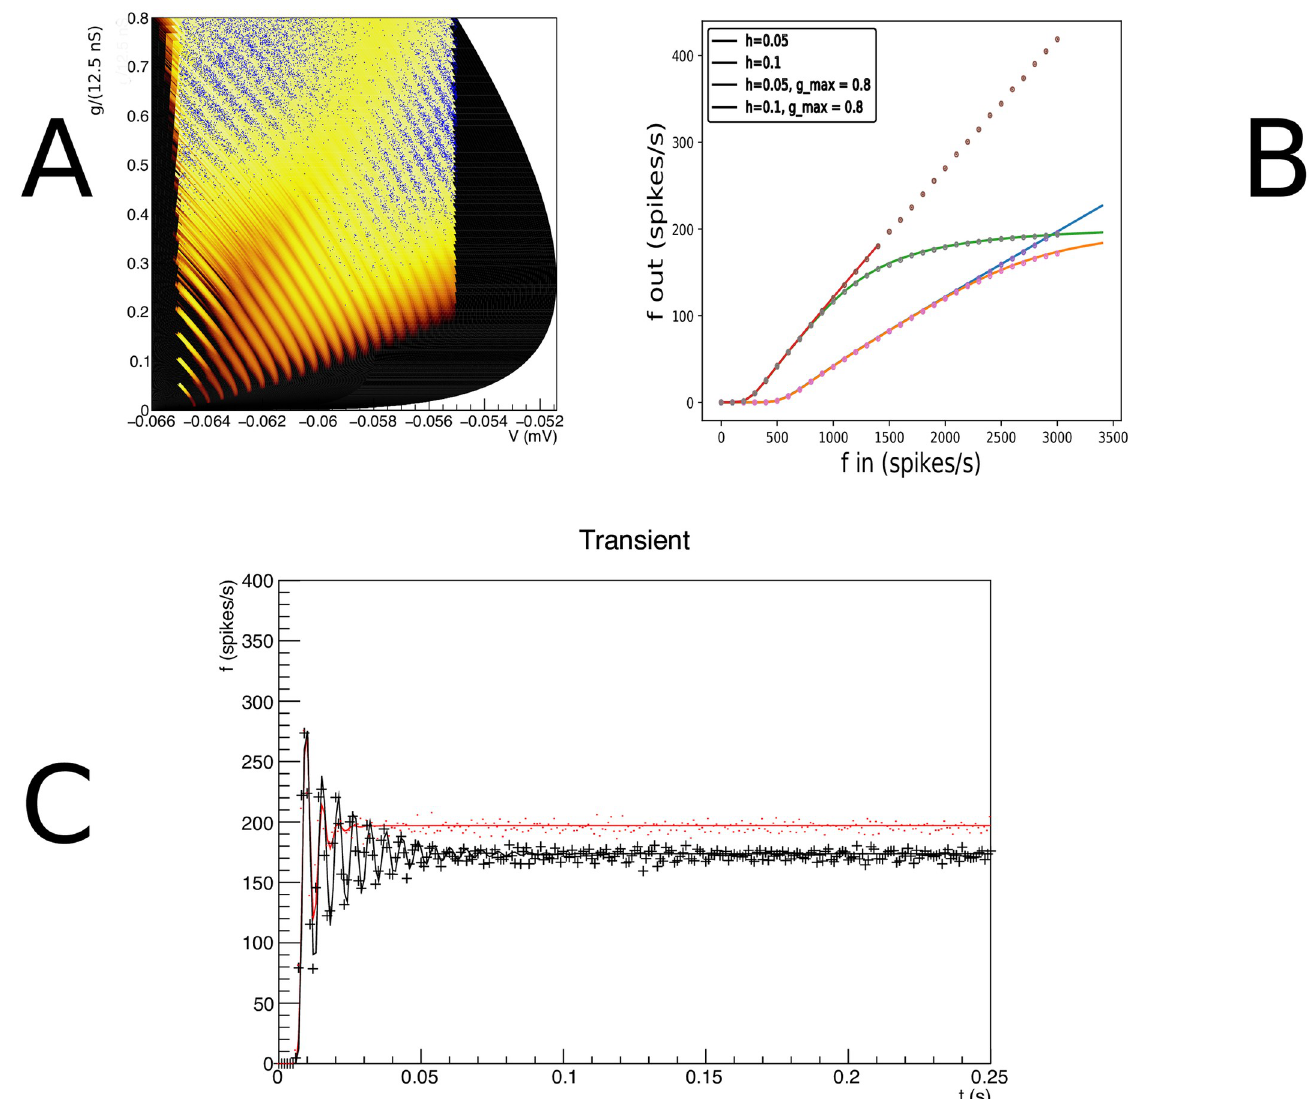
Fig 5. A: The density at t = 15 ms. Events are reflected against a reflecting conductance boundary. B: Gain curves for different input rates and synaptic efficacies. The maximum conductance clearly affects the shape of the gain curves, although at input rate 3 kHz for J = 1 mV the effect is moderate. C: The transient looks very different in the case where a maximum conductance is present (red): the “ringing effect” is much stronger, compared to the case without maximum (black), while the overall firing rates do not differ greatly. The cause can be seen in A: neurons have not had time to disperse before they are forced across threshold; clear groupings can be seen at the maximum